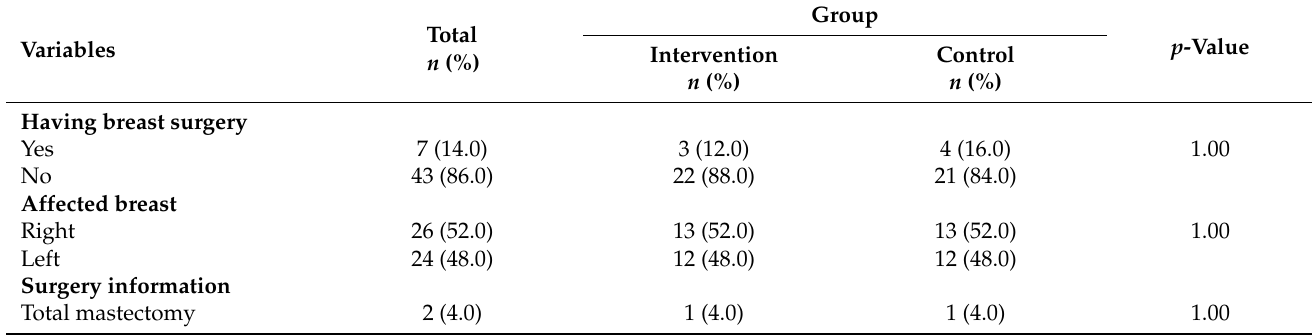
Table 3. Data related to the disease, treatment, and